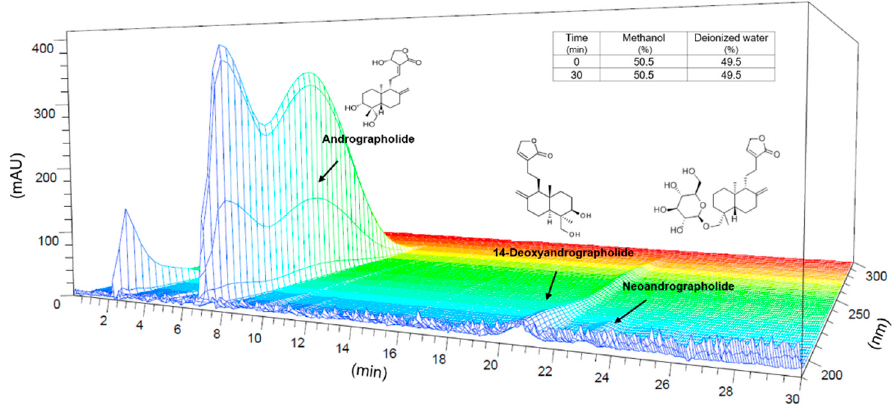
Figure 1. 3-D high performance liquid chromatography (HPLC) chromatogram of Andrographis paniculata extract. The X-axis is retention time, Y-axis is wavelength, and Z-axis is absorbance unit.